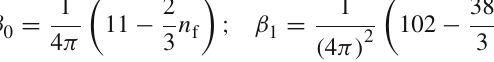
Fig. 9 Comparison of the values of α s ( Q ) obtained from fits to the TEEC functions at the energy scales given by (cid:4) H T2 (cid:5) / 2 (red star points) with the uncertainty band from the global fit (orange full band) and the 2016 world average (green hatched band). Determinations from other experiments are also shown as data points. The error bars, as well as the orange full band, include all experimental and theoretical sources of uncertainty. The strong coupling constant is assumed to run according to the two-loop solution of the